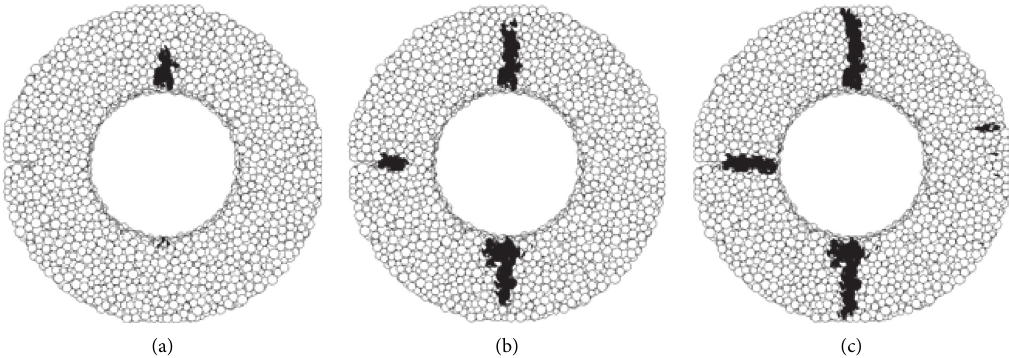
Figure 25: Microcracks distribution in ECFR specimen (B4). (a) Crack initiation. (b) Crack growth. (c) Sample